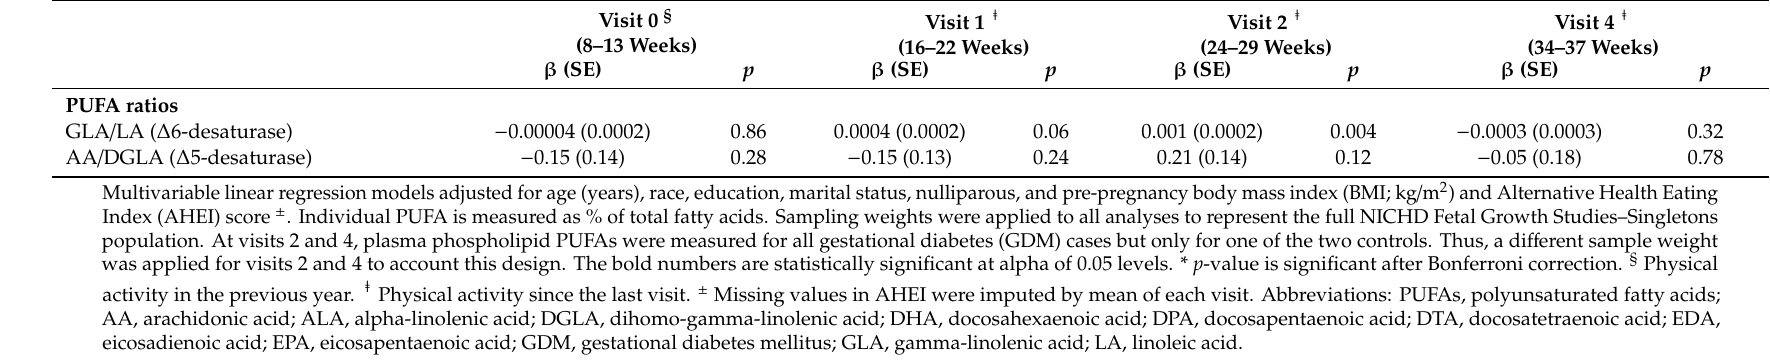
Table 2. Time-specific associations of maternal moderate-to-vigorous physical activity (MVPA) and plasma phospholipid polyunsaturated fatty acids (PUFAs) at each study visits in the NICHD Fetal Growth Studies–Singleton Cohort.